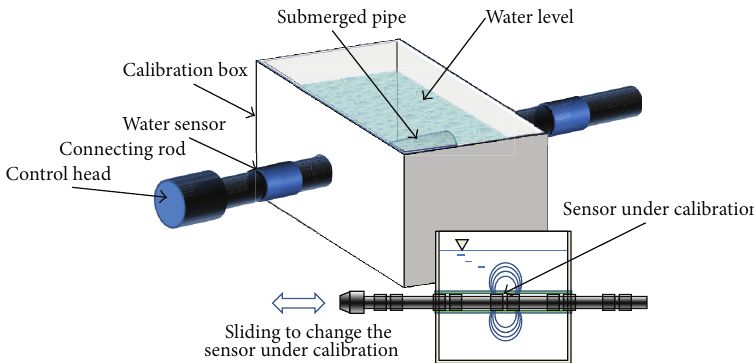
Figure 2: The calibration box of the capacitance probe to measure readings in